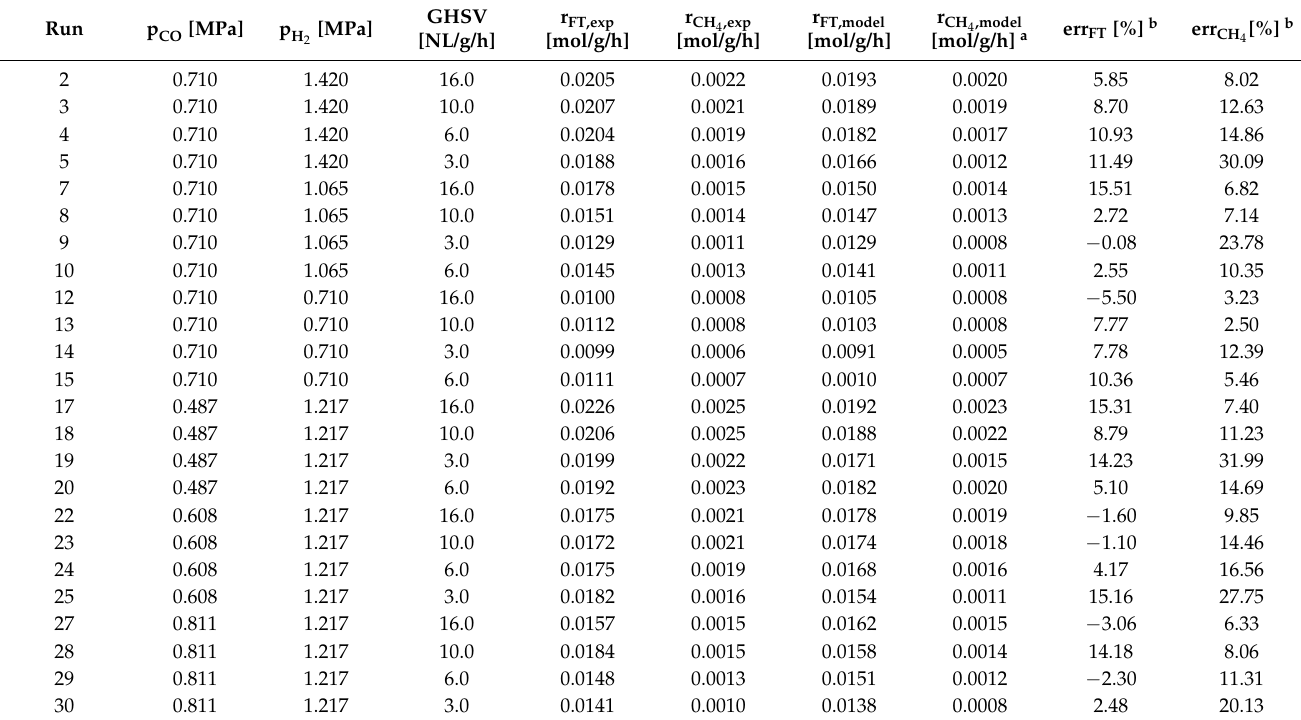
Table A1. Comparison of the experimental [48,49] and modeled reaction